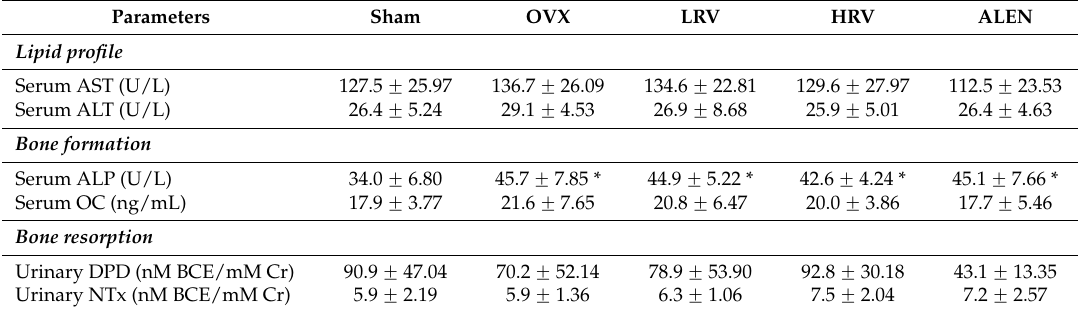
Table 1. Lipid profile parameter and biochemical markers of bone formation and resorption.